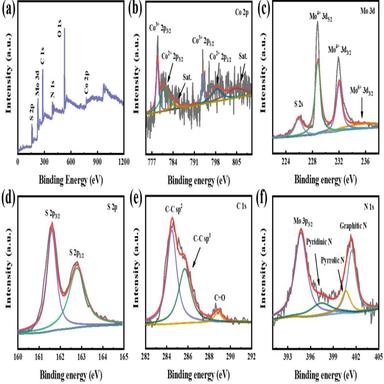
XPS spectra of the CoS2-MoS2@rGO composite: (a) survey, (b) Co 2p, (c) Mo 3d, (d) S 2p, (e) C 1 s, (f) N 1 s.